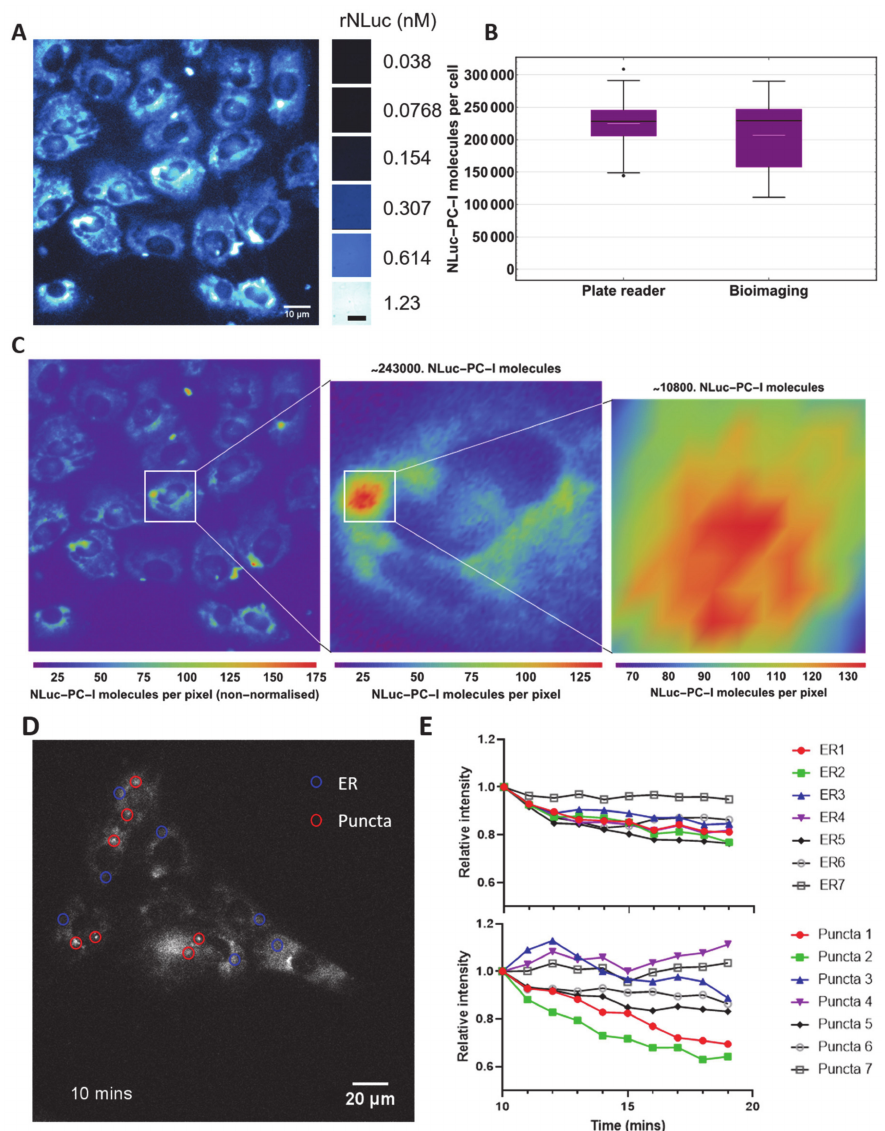
Figure 3. Quantitation at single cell and subcellular levels. ( A ) Bioluminescence imaging of nluc::Col1a2 cells. Colourised bioluminescence image of NLuc-PC-I immediately following the addition of the substrate Furimazine to 21 cells. Images were taken every minute for 5 min, and the data summed. Adjacent, summed images of rNLuc used for quantitative correlation, scale bar represents 100 µ m. Analysis of images is shown in Figure S4. ( B ) Quantitation of NLuc-PC-I molecules per cell using bioluminescence imaging of 21 cells were compared to estimates from all plate reader measurements. The black line within the box shows the median value, and the white dash the mean value. The fences show maximum and minimum values (excluding outliers). ( C ) Scaled image of ( A ) showing the number of NLuc-PC-I molecules per pixel. NLuc-PC-I was found to be concentrated in puncta, quantitation of a single subcellular vesicle containing 10,800 molecules at a concentration of 0.231 mg / mL or 0.479 µ M, assuming a spherical vesicle. ( D ) Bioluminescence imaging of nluc::Col1a2 cells with regions of endoplasmic reticulum (ER, blue circles) and puncta indicated (red circles). ( E ) The change in bioluminescence over 10 min of imaging in the seven indicated regions of ER and puncta is shown in ( D